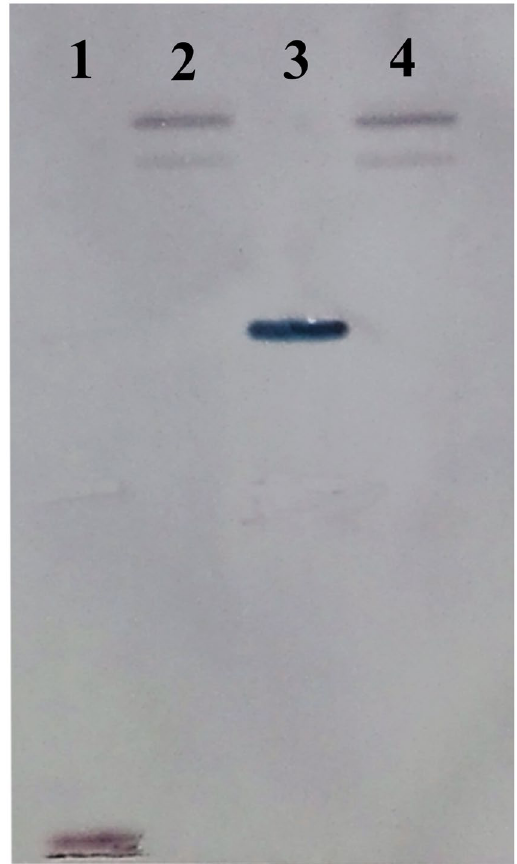
Figure 4. Southern blot analysis of Radopholus similis Rs - scp - 1 . 1, 3: pTA2-gscp digested with EcoR I and Hind III; 2, 4: R . similis gDNA digested with EcoR I and Hind